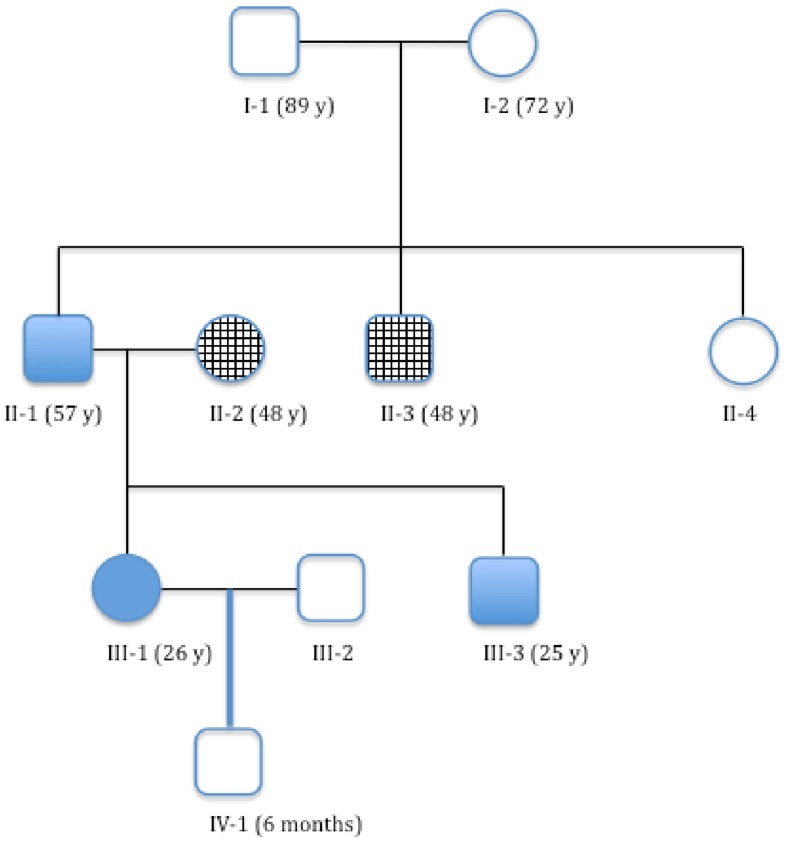
Current family tree (2012) showing the affected members; Each generation tested is marked with roman numeral; squares represent male and circles female; blank squares and circles represent members who were not tested; checkered were tested and found negative and blocked were positive for mutation.